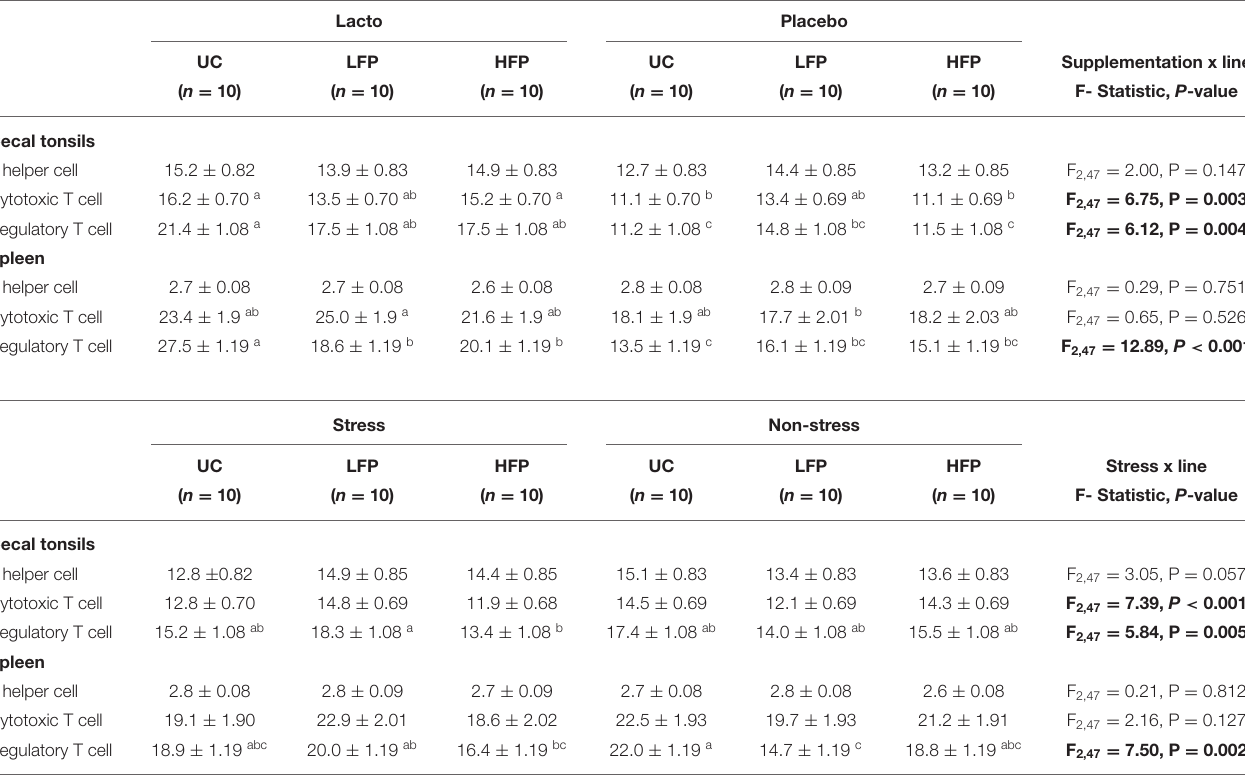
TABLE 2 | Least squares means ( ± standard error) of the proportions of T cell sub-populations in the spleen and cecal tonsils in 38 weeks old birds according to their genetic line (UC: unselected control, LFP: low feather pecking line, HFP: high feather pecking line). Lacto Placebo UC LFP HFP UC LFP HFP Supplementation x line F- Statistic, P